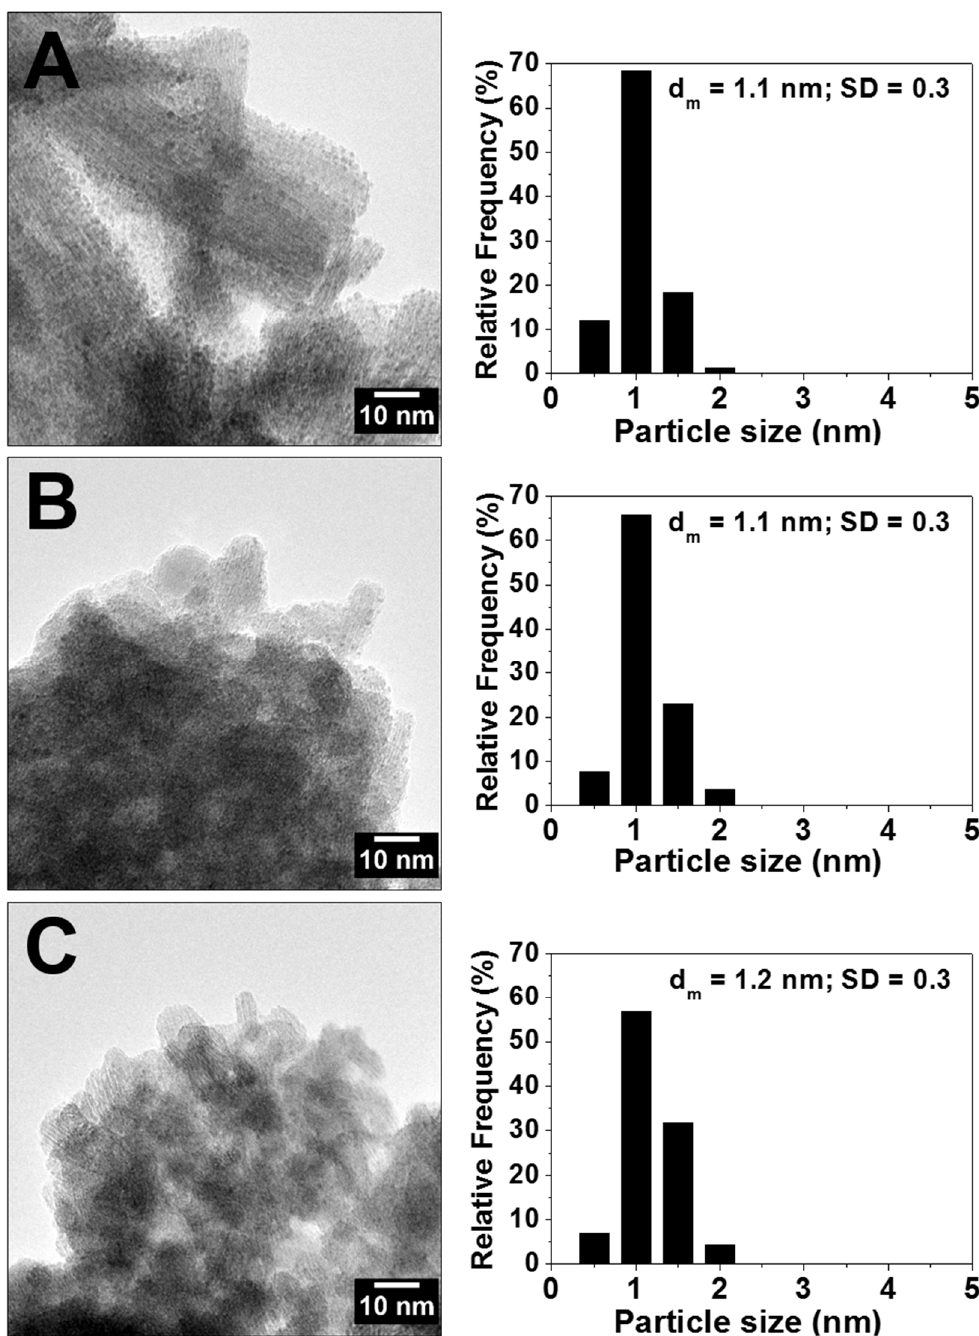
Figure 3. Representative Transmission Electron Microscopy (TEM) micrograph (315,000 X) and histogram of Pt particle size distribution of the Pt/Nb 2 O 5 ( A ), Pt/Ti-Nb 2 O 5 ( B ) and Pt/W-Nb 2 O 5 ( C ) sample.